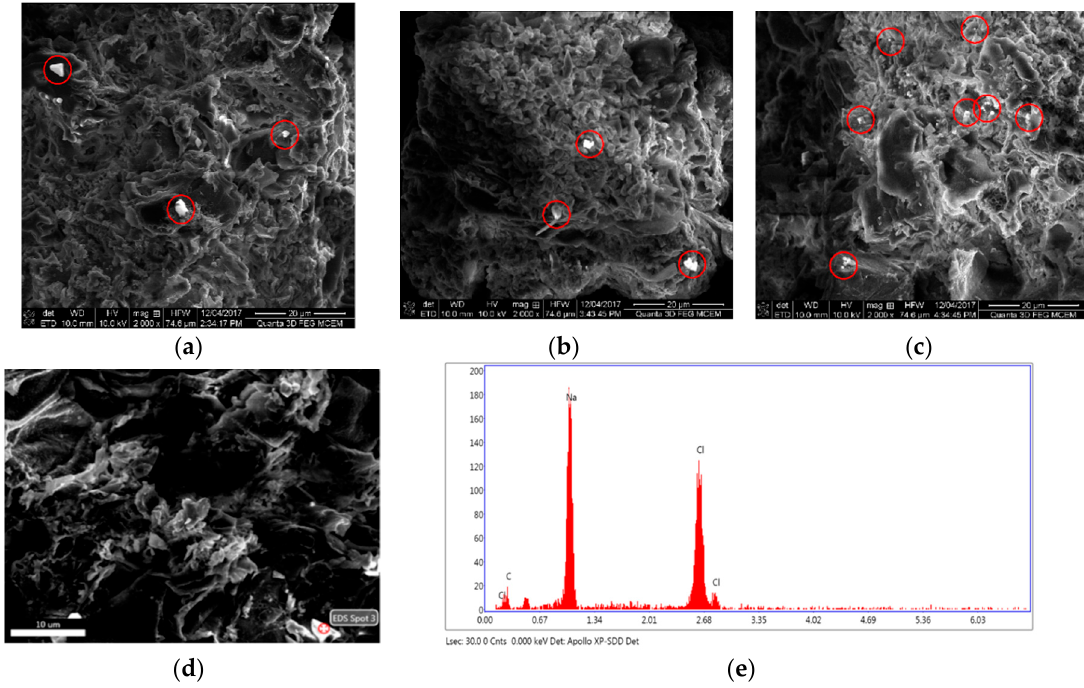
Figure 4. SEM images of ( a ) 5%, ( b ) 15% and ( c ) 25% brine-saturated samples (White crystals inside the red circles are NaCl crystals. Images were taken under accelerated voltage of 10 kV, with 47 pA probe current and magnification of 2000×) ( d ), ( e ) Energy dispersive X-ray spectroscopy (EDS) analysis of precipitated white crystals.